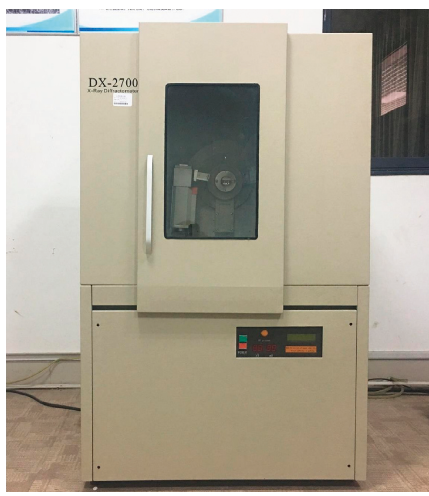
Figure 2: X ′ Pert Pro MPD diffractometer.